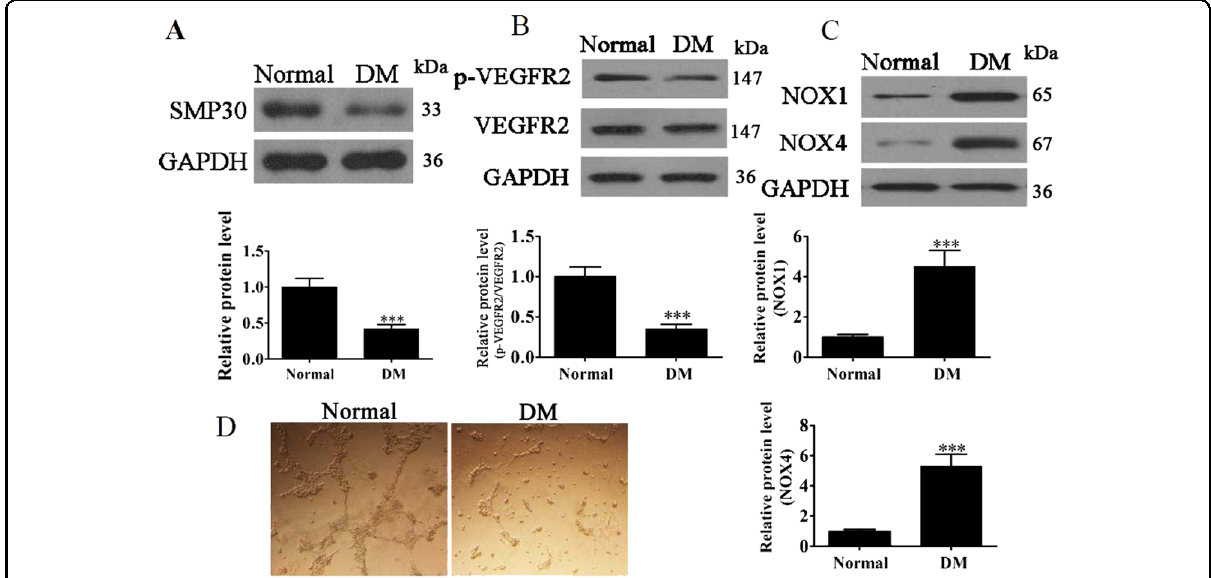
Fig. 2 Expression of SMP30 and oxidative stress-related proteins on circulating CD34-positive cells of patients with diabetes mellitus (DM) and healthy controls. a Expression of senescence marker protein 30 (SMP30) was measured by western blot. GAPDH served as an internal control. The relative protein levels were analyzed, and data are presented as the mean ± SD ( n = 3). *** P < 0.001 vs. normal group. b Phosphorylation of VEGFR2 was measured by western blot. GAPDH served as an internal control. The relative protein levels were analyzed, and data are presented as the mean ± SD ( n = 3). *** P < 0.001 vs. normal group. c Levels of the ROS-related proteins NOX1 and NOX4 were measured by western blot. GAPDH served as an internal control. The relative protein levels were analyzed, and data are presented as the mean ± SD ( n = 3). *** P < 0.001 vs. normal group. d The tube formation capability of endothelial progenitor cells (EPCs) from DM patients or subjects without DM was measured. The results show that the tube formation capability of EPCs decreased in DM